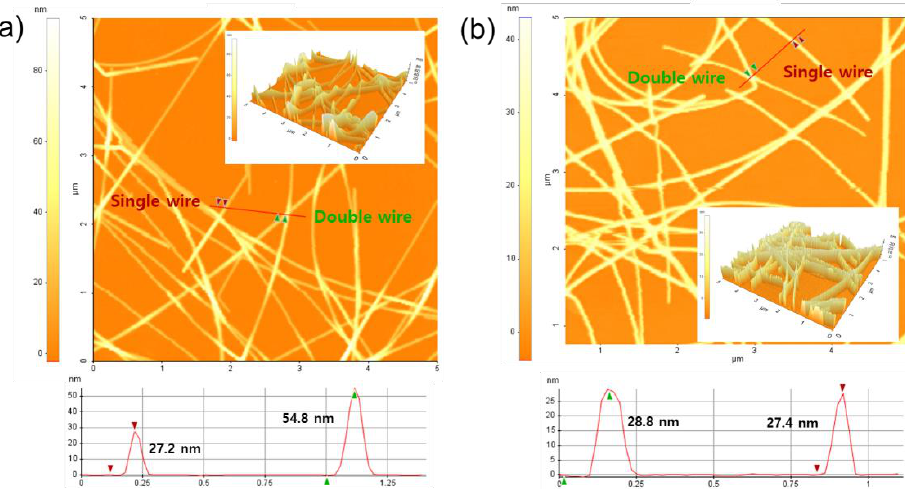
Figure 4. Atomic force microscopy (AFM) image and the AFM height differences between the single AgNW junction and the double AgNW junction ( a ) with 20 AgNW spray coatings (before pressurizing) and ( b ) the AgNW nanomesh after pressurizing with 2000 N/cm 2.